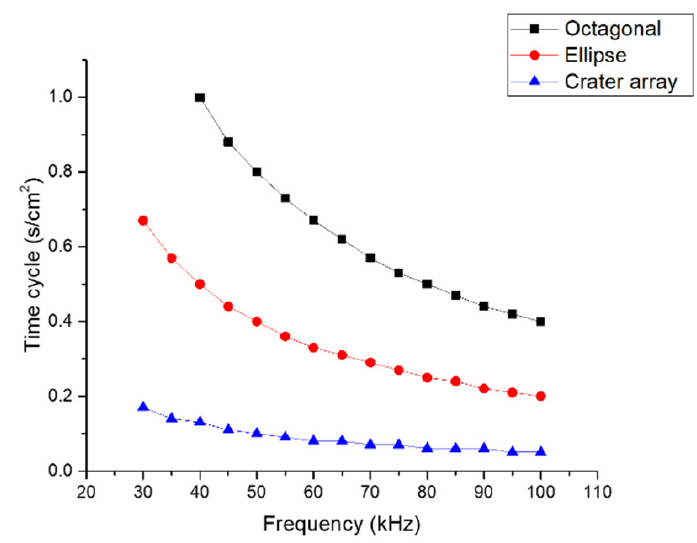
Figure 2. Time cycle vs. frequency.